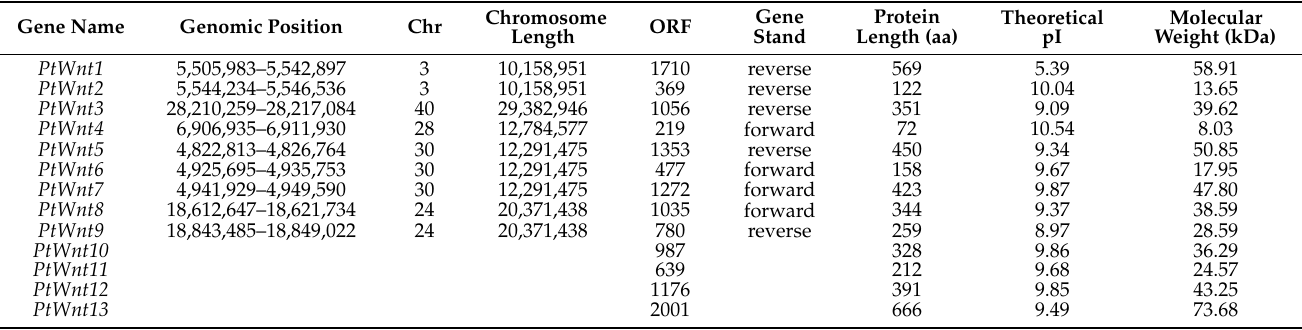
Table 1. The identification of Wnt gene family members in P. trituberculatus